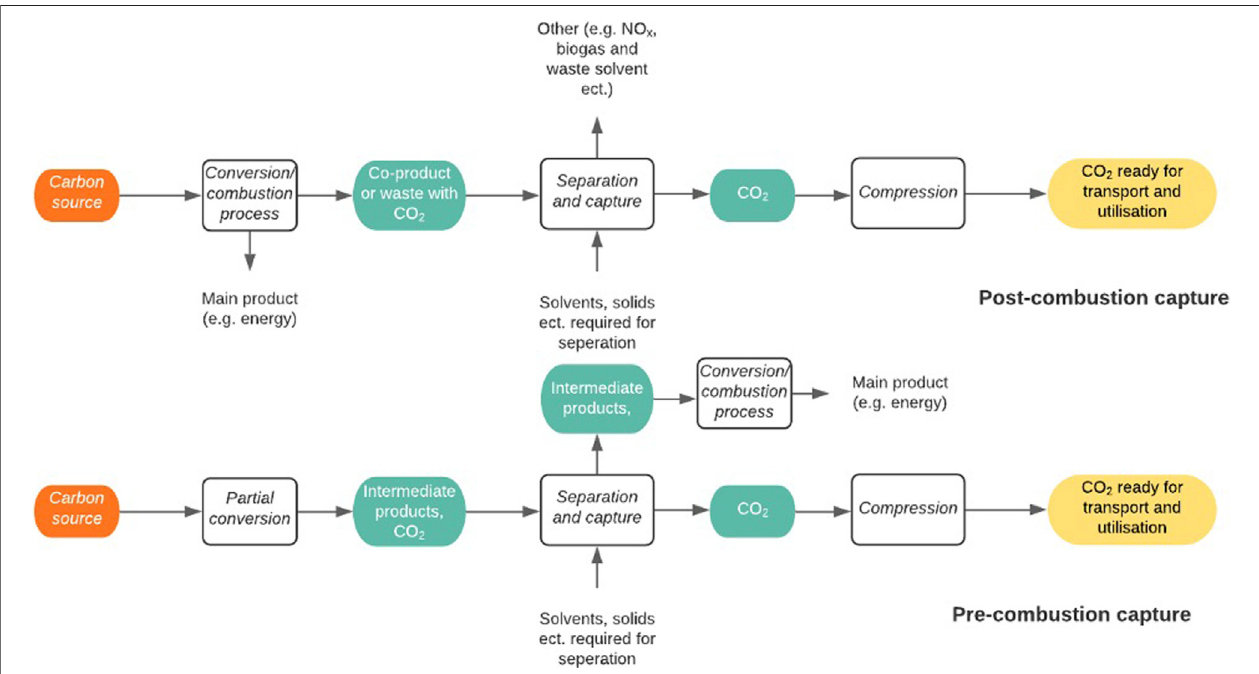
FIGURE 9 | CO 2 capture pathways for CCS and